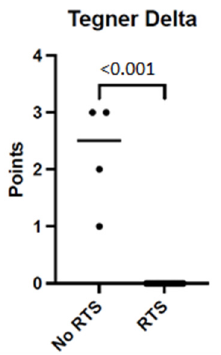
Figure 3. Median loss of activity according to Tegner activity scale, no RTS vs. RTS. Scatter plot. Significant difference in median Tegner Delta (points) for patients with no return to the preferred sports activity vs. patients who accomplished RTS until follow up, p < 0.001. RTS = return-to-sports.